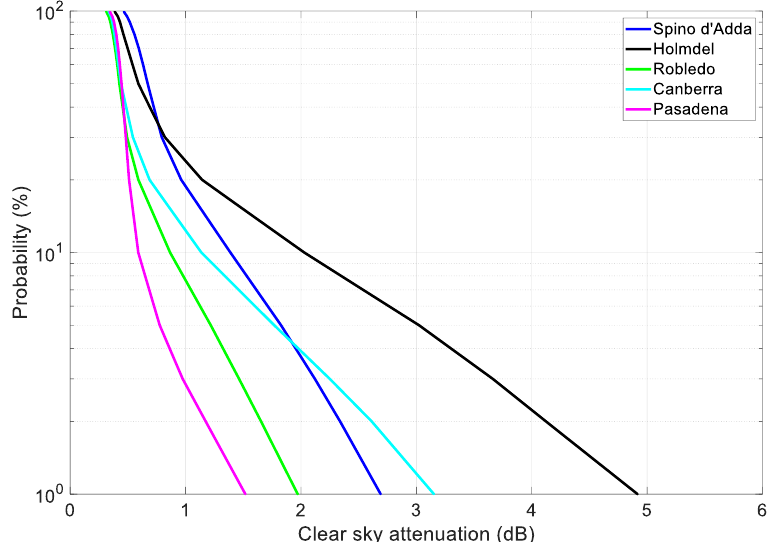
Figure 12. Annual probability distributions of clear-sky attenuation exceeded in the GEO paths on the local meridian at the reference sites.